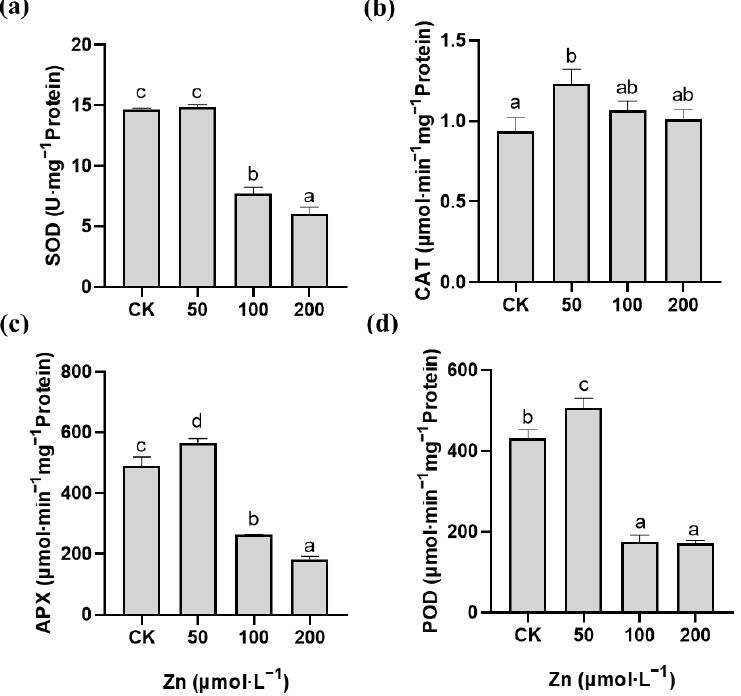
Figure 7. Activity of SOD ( a ), CAT ( b ), APX ( c ) and POD ( d ) in roots of M. cordata grown hydropon- ically under control (CK) and varied concentrations of Zn for seven days. Values are means ± SE ( n = 3) with three separate replicates. Means denoted by different letters refer to the significant differences ( p < 0.05, Duncan’s test).